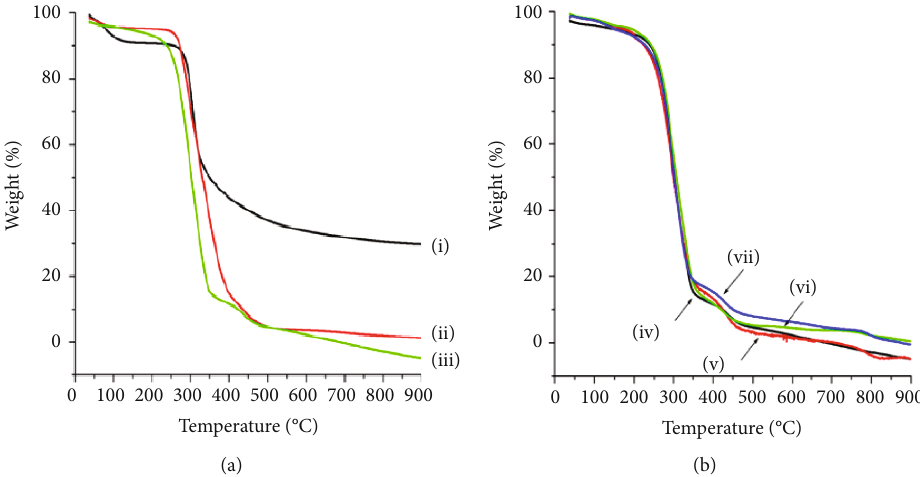
Figure 10: TGA curves of the (a) (i) pure PVA, (ii) pure CS, (iii) 30/70 CS/PVA blend, and (b) (iv) 0.1wt%, (v) 0.2wt%, (vi) 0.3wt%, and (vii) 0.4wt% Ag/Cu/CS/PVA. Voltage: 20kV; distance: